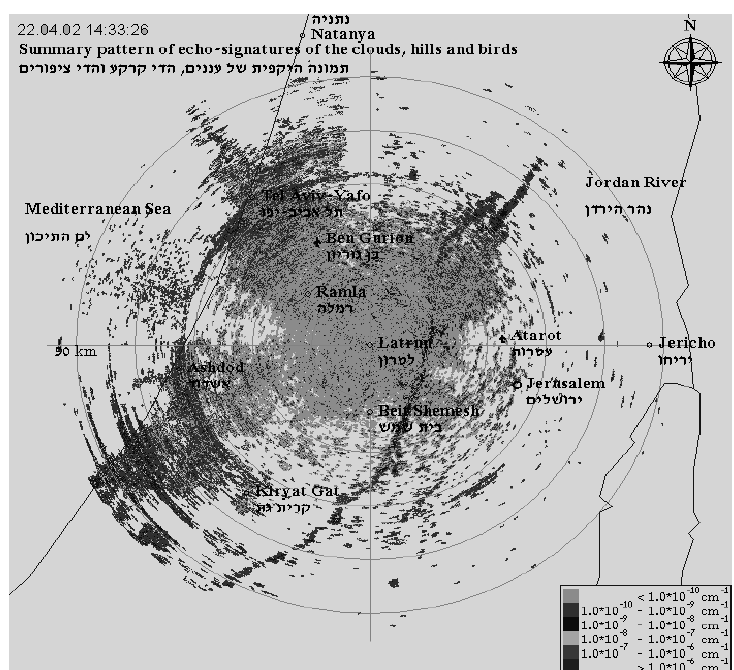
Рис. 2. Миграция осоеда, 22 апреля 2002 г., 14:30 PM (по результатам обработки радарных